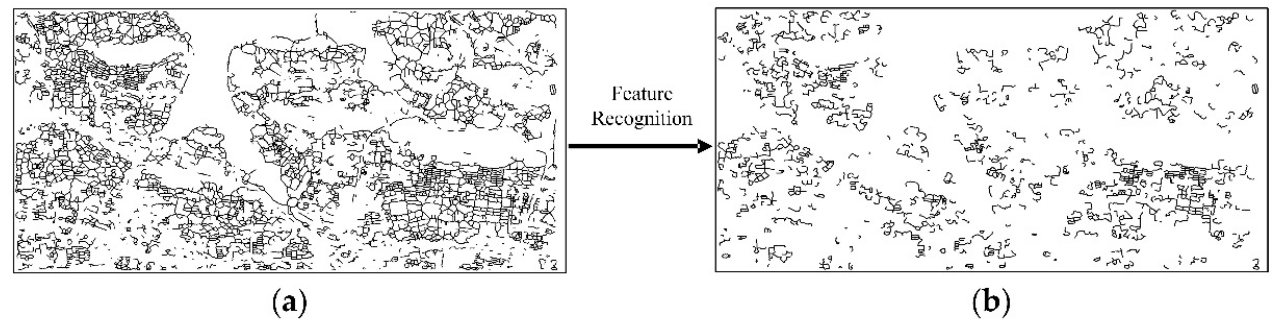
Figure 16. Experiments of feature recognition: ( a ) skeleton lines; ( b ) retained skeleton lines.